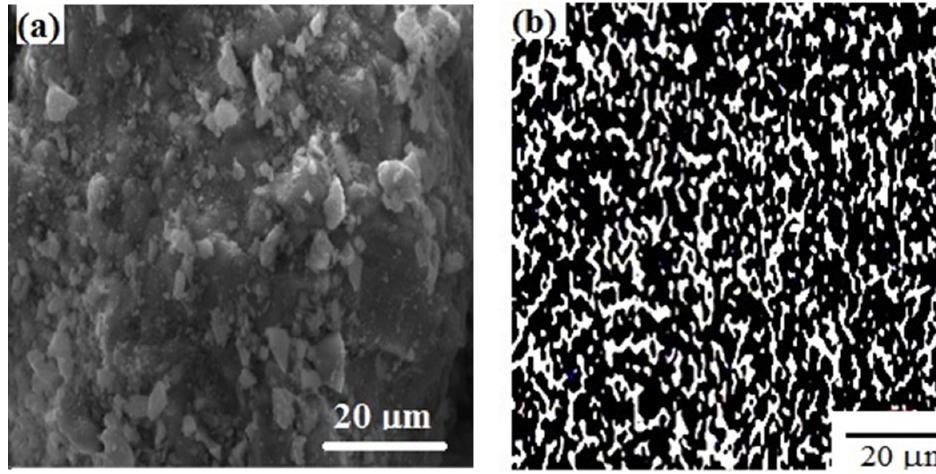
Figure 2. Photomicrographs of iron ore fines sample ( a ) SEM (5000×) ( b ) RLM (500×).